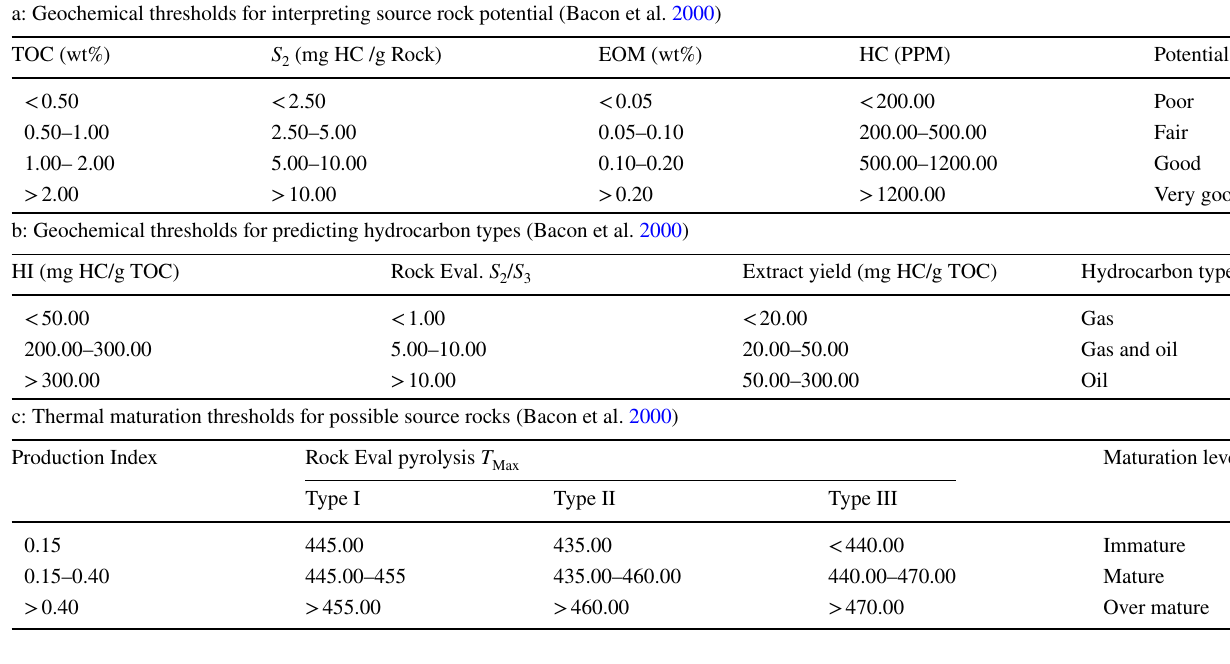
Table 3 Established geochemical thresholds for qualitative and quantitative assesments of petroleum source rocks a: Geochemical thresholds for interpreting source rock potential (Bacon et al. 2000)